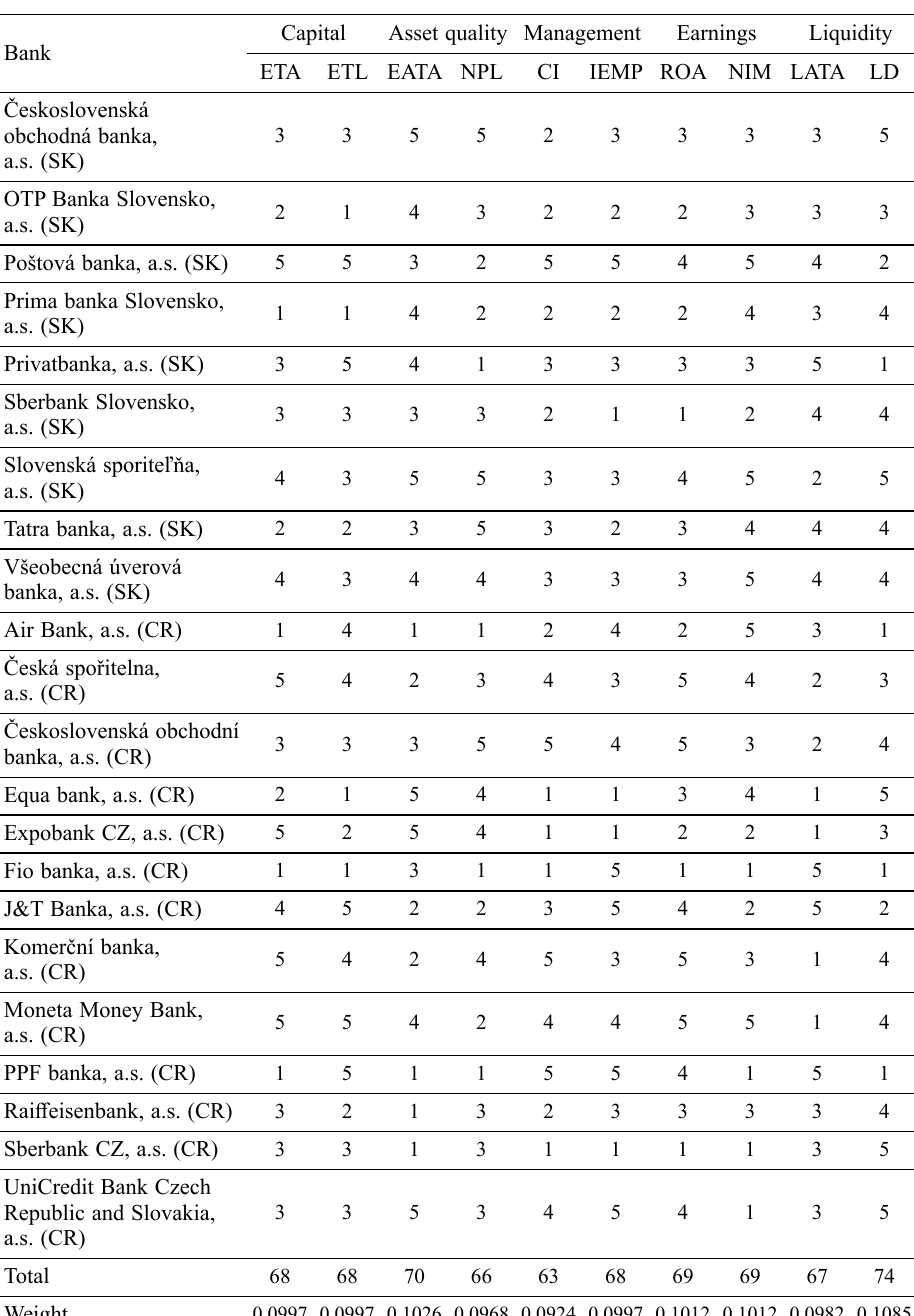
Table 1. Determination of weights by scoring method based on scaling Capital Asset quality Management Earnings Liquidity Bank ETA ETL EATA NPL CI IEMP ROA NIM LATA